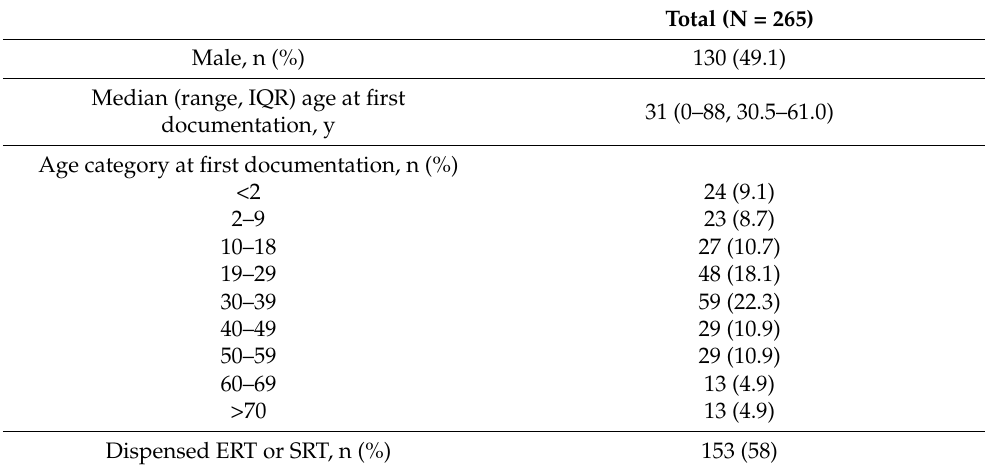
Table 2. Characteristics of 265 cases with confirmed Gaucher